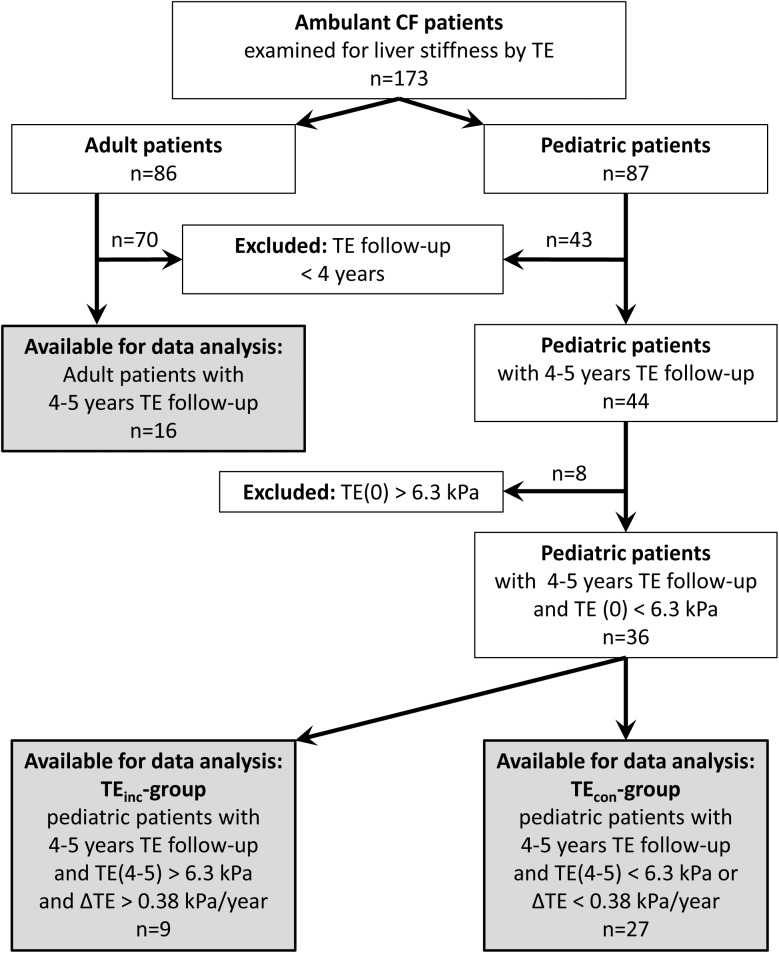
Derivation of study cohort.TE = Transient elastography.